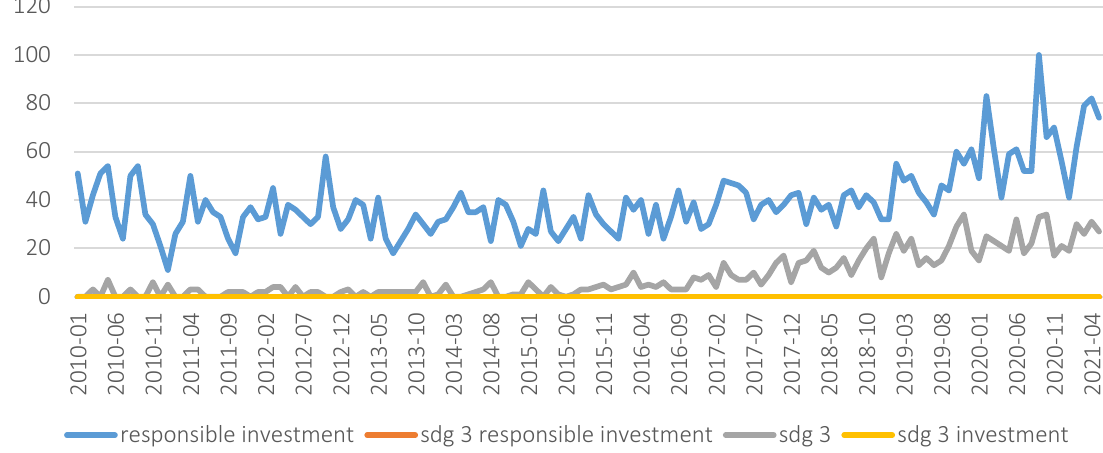
Figure 5. Internet queries concerning “SDG 3,” “SDG 3 and investment,” “SDG 3 and